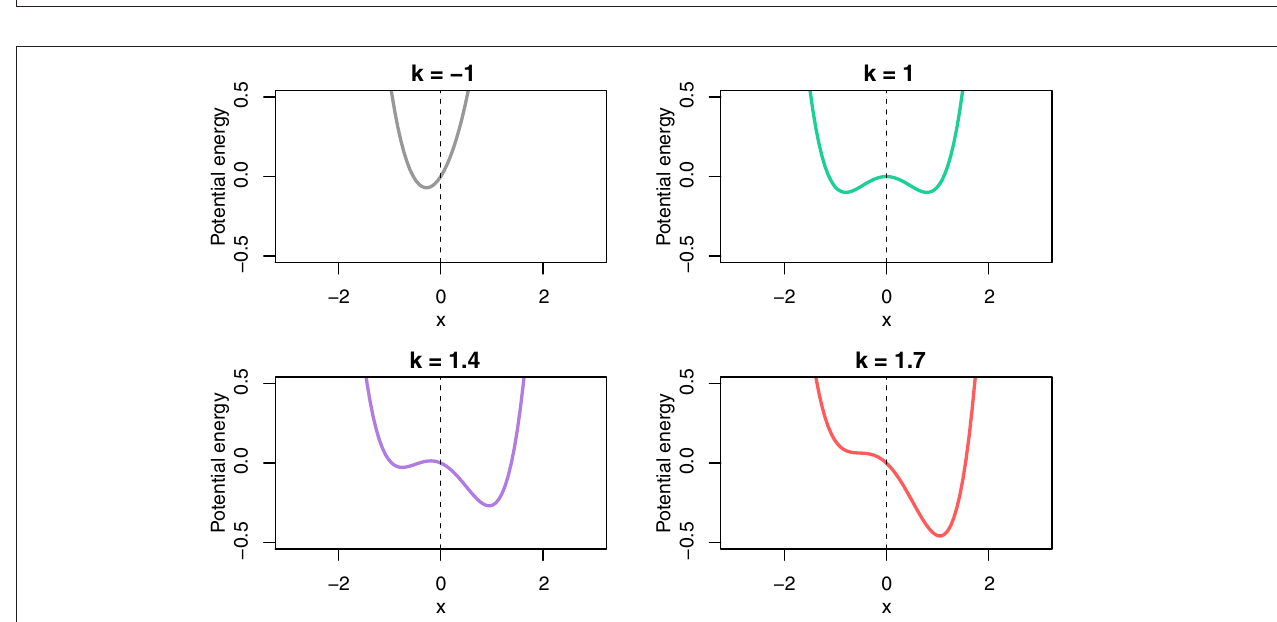
FIGURE 8 | Bifurcation in a dynamical system as the results of the scaling of the control parameter k .